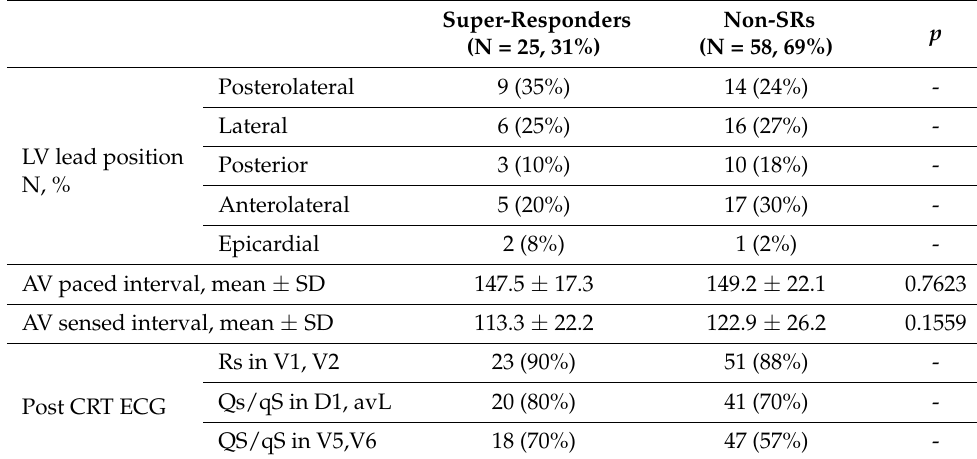
Table 2. Technical aspects in the SR and non-SR